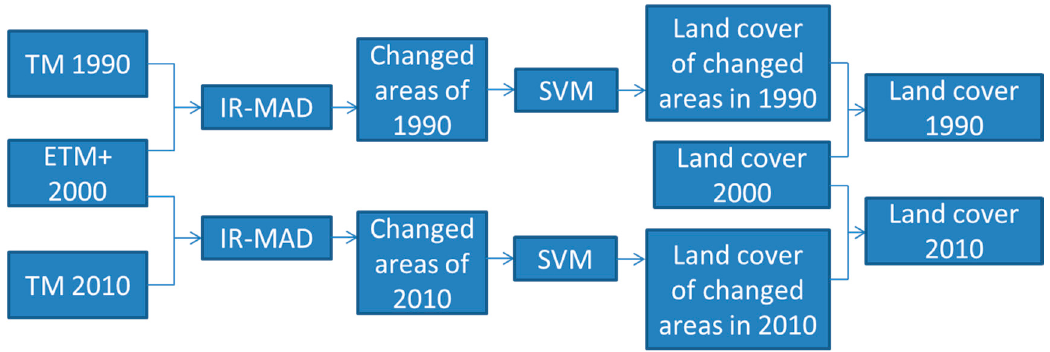
Figure 3. Flow diagram of the land cover change classification.